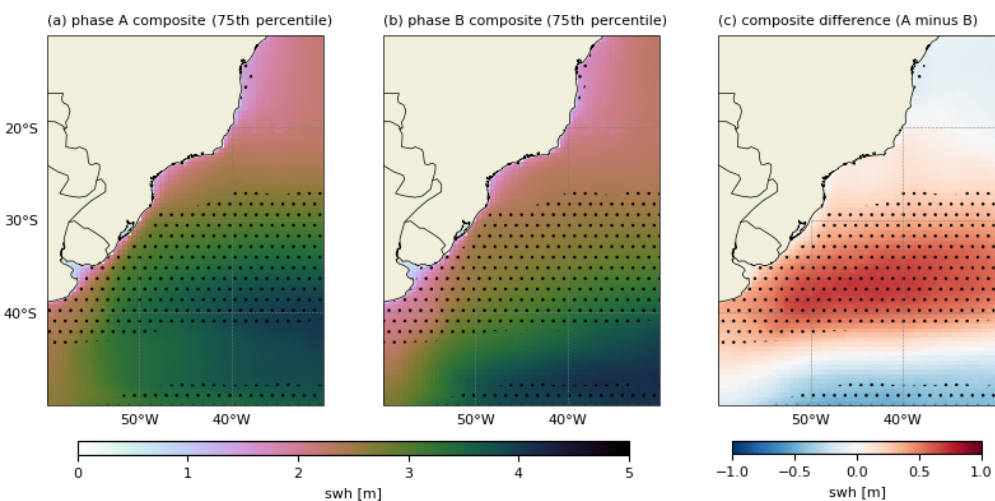
Figure 8. Composites (75th percentile) of swh calculated using phases (a) A and (b) B of the EOF2 of u 10 and (c) difference between the composites. The black dots represent areas where the difference between phases is within a 95% confidence